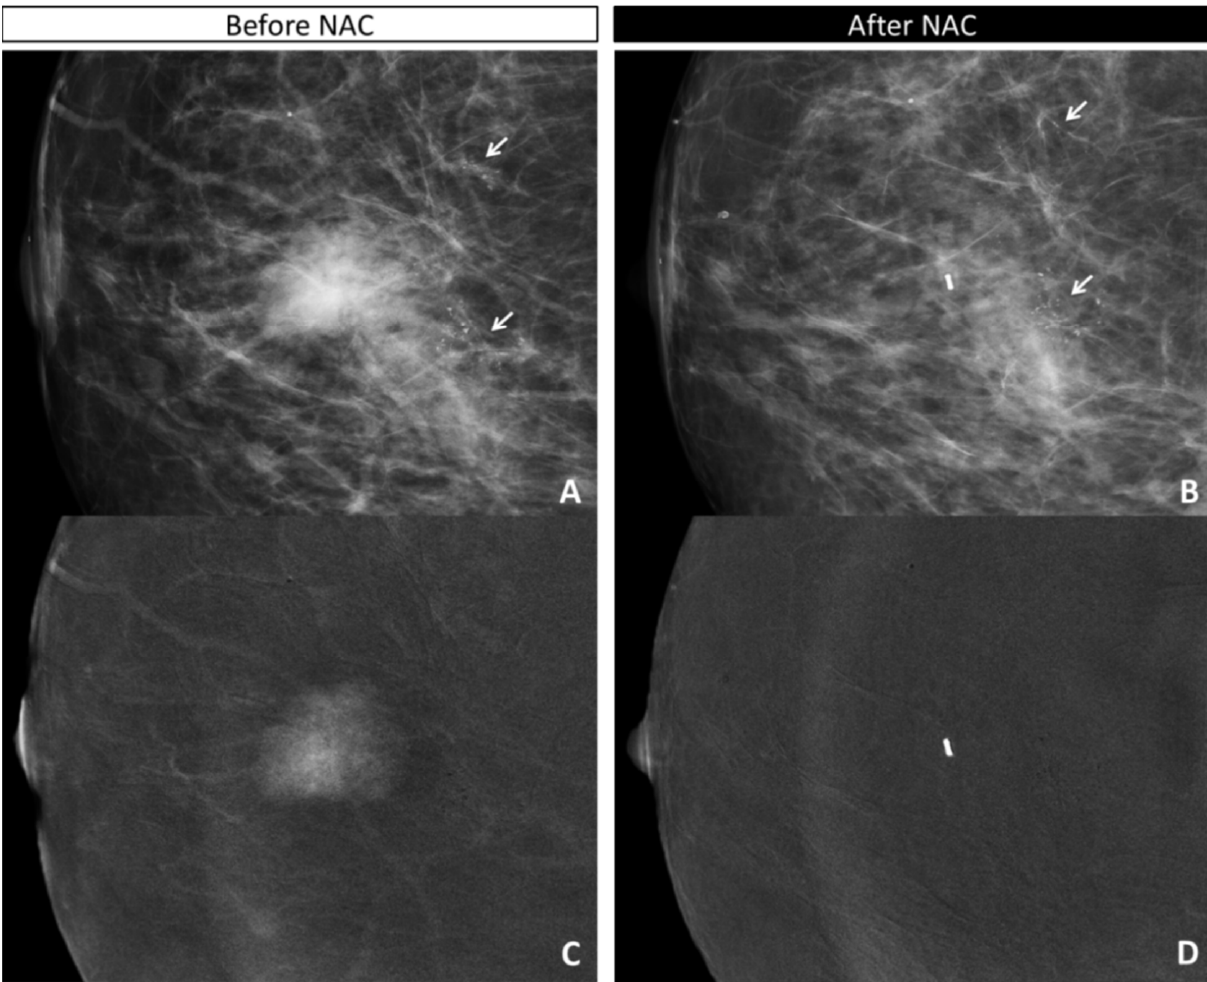
Figure 2. True positive for the combined evaluation and false negative on the CE-only evaluation: 55-yo woman with IDC G2 HER2+ with opacity and nearby, two clusters of pleomorphic calcifications in right breast ( A , C : CC low-energy image; arrows). The in situ component was seen only on the surgical specimen. The opacity showed a strong mass enhancement before NAC ( C : CC recombined image), while the clusters of calcifications showed no or only faint enhancement. After NAC ( B : CC low-energy image; D : CC recombined image), the calcifications in both clusters decreased slightly ( B , arrows); no residual enhancement was visible surrounding the marker placed in the tumor bed of the opacity. The analysis of the surgical specimen revealed 12 mm of residual IDC and multiple foci of DCIS (ypT1c).